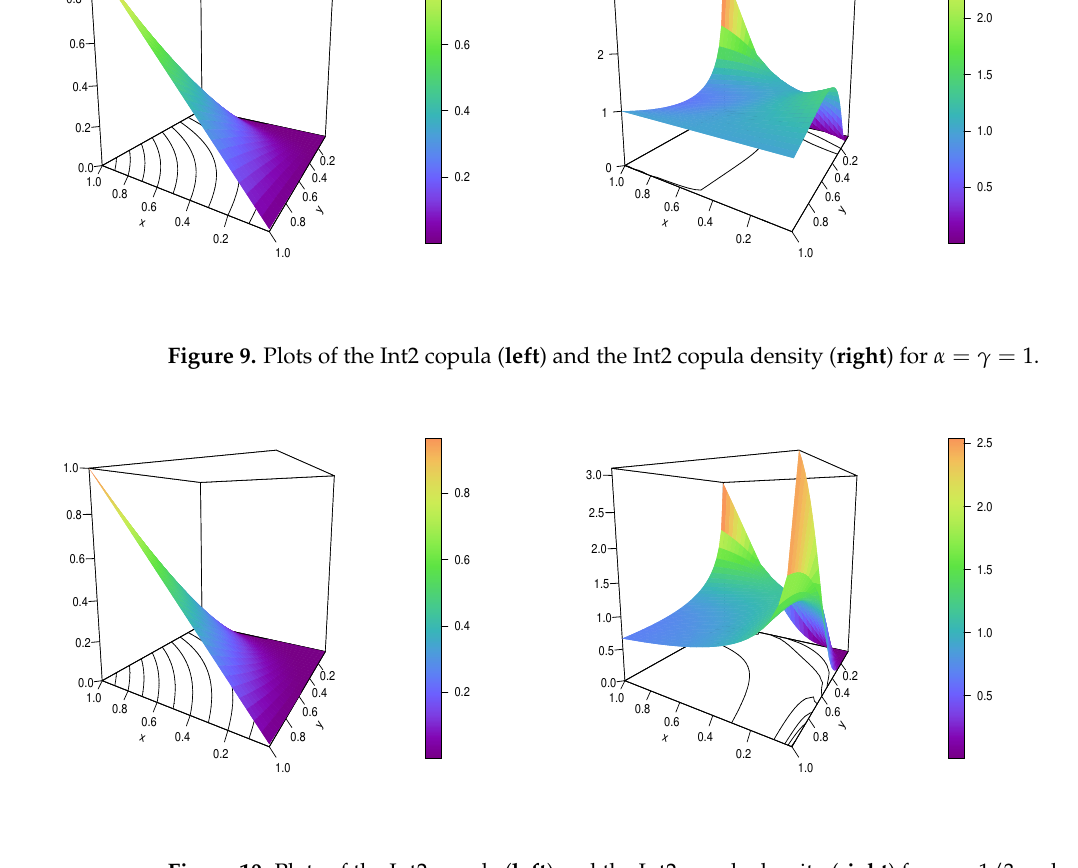
Figure 10. Plots of the Int2 copula ( left ) and the Int2 copula density ( right ) for α = 1/3 and γ =